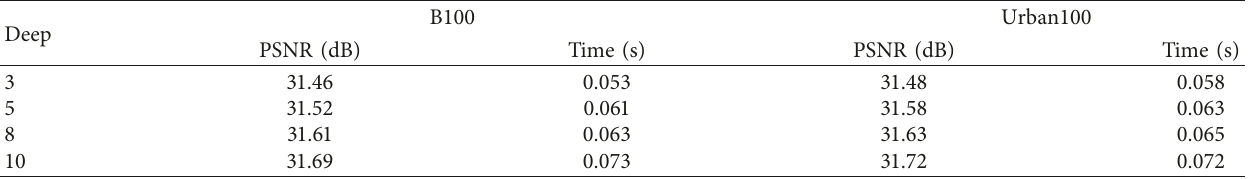
Table 1: Choice of depth at each